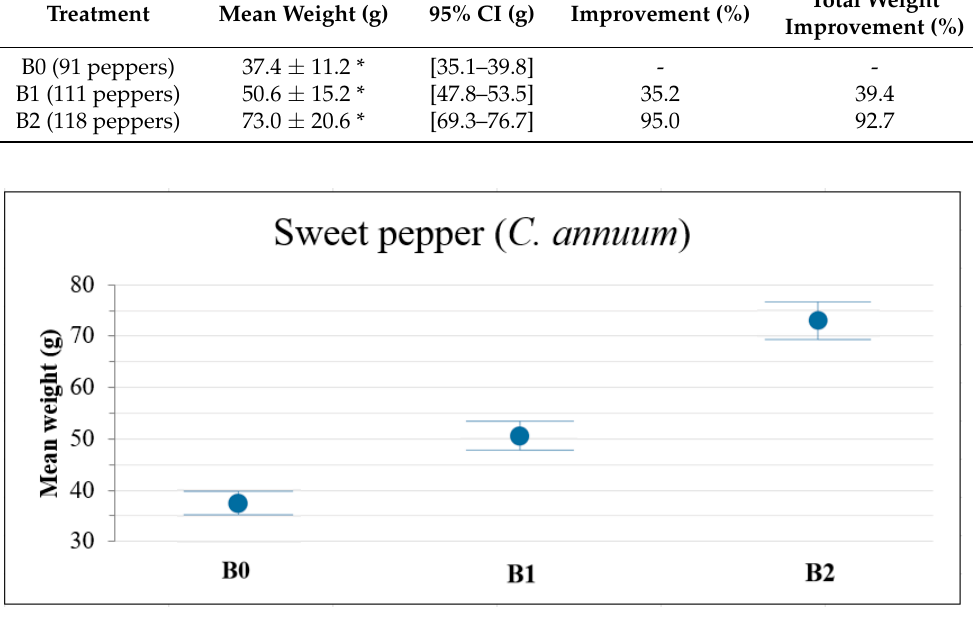
Figure 6. Mean sweet pepper weight and confidence interval of each treatment ( α =